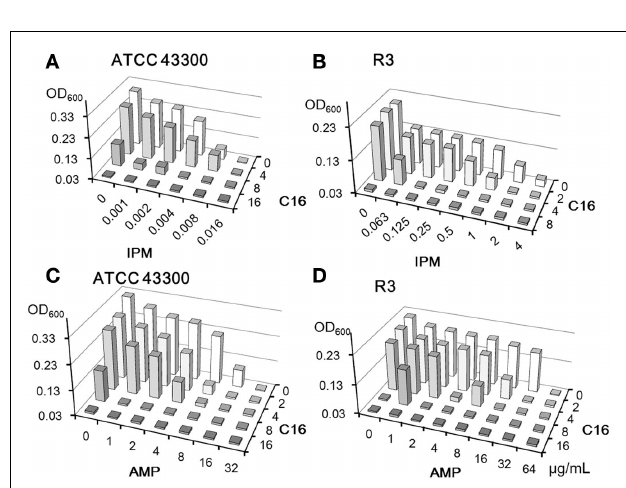
incubation were counted as colonies grown on the Mueller–Hinton agar plates. Mean ∓ SD of the residual CFUs calculated from two to four plates are shown.